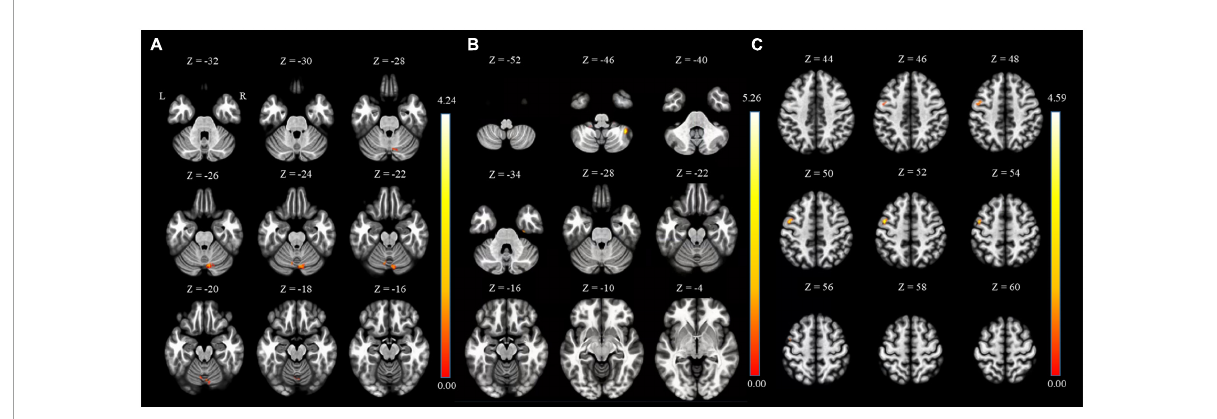
FIGURE1 Regions of HC > MDD functional connectivity in the seed-to-voxel analysis. (A) L-Cerebellum_6 connected with L-Habe seed (MNI coordinates: X = –08, Y = –66, Z = –22), (B) R-Cerebellum_7b connected with R-Habe seed (MNI coordinates: X = + 40, Y = –50, Z = –46) but not significant on statistically. (C) PreCG_L connected with septal seed (MNI coordinates: X = –46, Y = + 00, and Z = + 52) but not significant on statistically. HC, Healthy controls; L-Cerebellum_6, Lobule VI of the left cerebellar hemisphere; L-Habe, Left habenula; MDD, Major depressive disorder; MNI, Montreal Neurological Institute; R-Cerebellum_7b, Lobule VIIB of the right cerebellum; R-Habe, Right habenula.